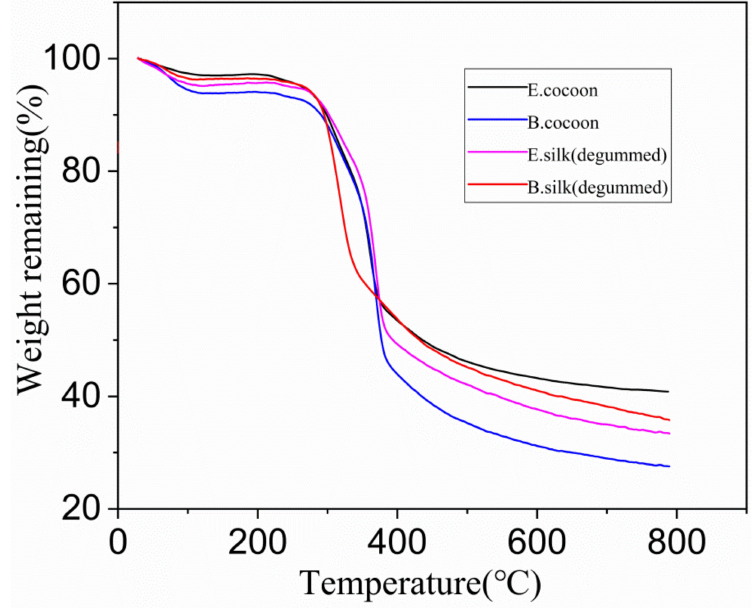
Figure 12. Thermogravimetric (TG) curves of cocoon shells and degummed fibers produced by E and B